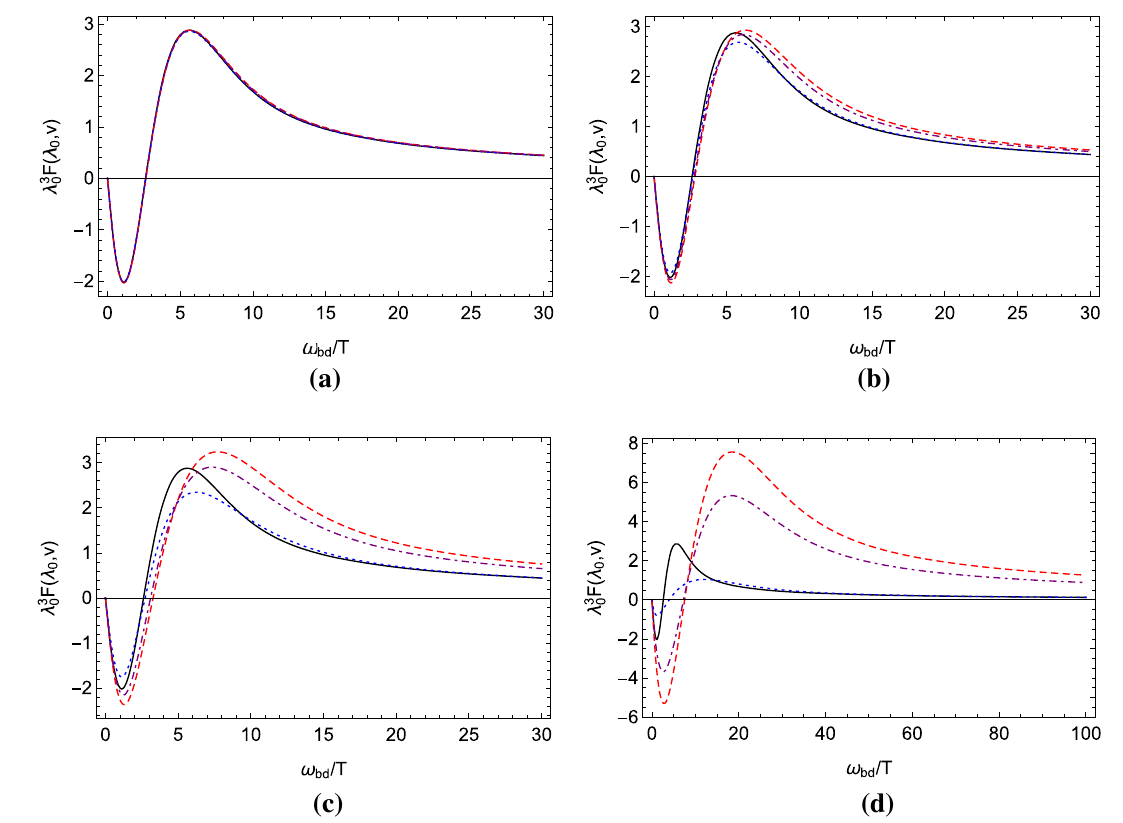
Fig. 1 Thebehaviorofthefunction λ 3 F (λ 0 ,v) withtheincreasein λ 0 . line refers to the case for a static atom in the same thermal radiation 0 ( v = 0). a The case for v = 0 . 1, b the case for v = 0 . 3, c the case for The dashed, dotted, and dot-dashed lines refer to the cases for an atom v = 0 . 5, d the case for v = 0 . polarizable perpendicular to the atomic velocity, parallel to the atomic velocity, and isotropically, respectively. As a contrast, the black solid